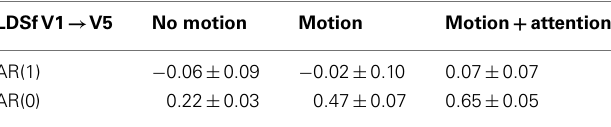
Table 1 | LDSf identified connectivity betweenV1 andV5 in during the attention to visual motion